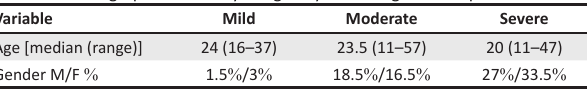
TABLE 2: Demographic summary of age in years and gender of patients. Variable Mild Moderate